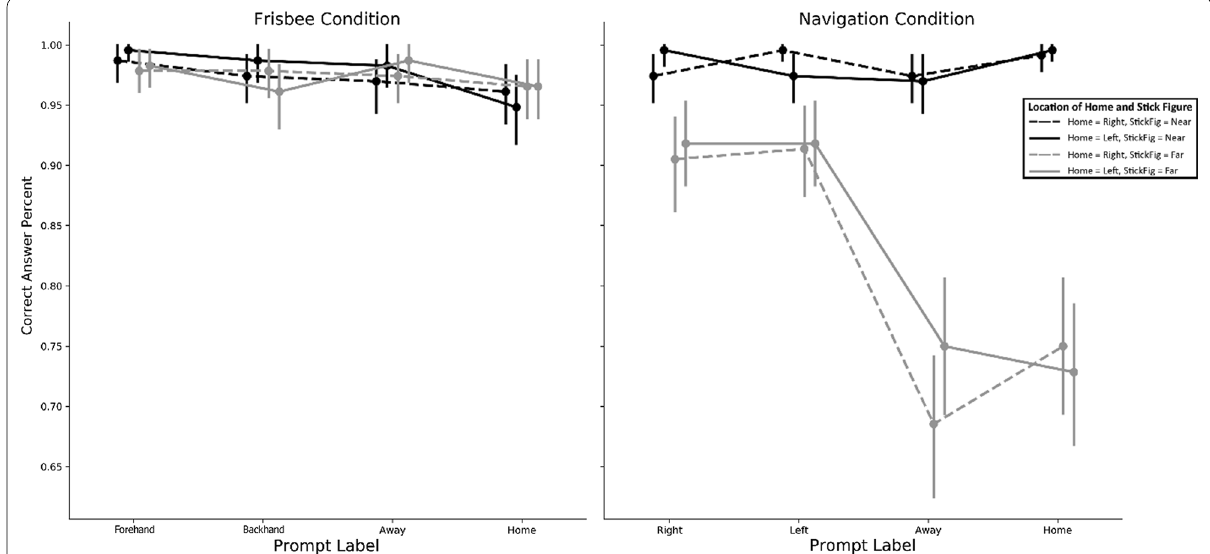
Fig. 5 Accuracy differences across ultimate frisbee and navigation conditions. Across all participants, accuracy was high on the ultimate frisbee task. A subset of participants (flippers) responded distinctly lower for Absolute prompts on the road intersection task (navigation